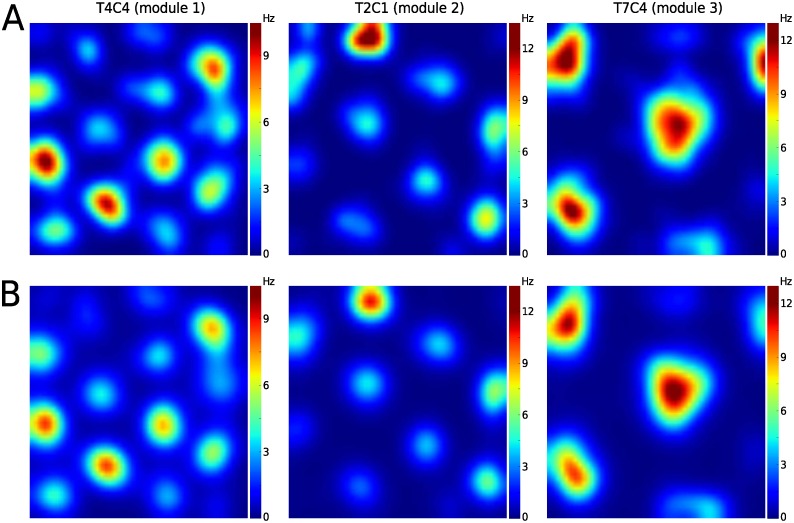
Grid cell spatial firing rate map.The smoothed rate maps from the original spike data (panel A) and synthetic spike data (panel B). Three example grid cells from the three different modules identified in data set 1 are shown here: left column, module 1 (T4C4 is cell identity—tetrode 4 cell 4), middle column, module 2, and right column, module 3. The synthetic data (panel B) was generated using Eq. 1 (with H
i(t) determined by the inferred values for the Gaussian basis functions plus a constant field) and the trajectory of the rat. The rate maps in both panel A and B were generated by first binning the spike data into 3 cm spatial bins, for which the mean rate was calculated and then smoothed using a Gaussian filter (standard deviation = 2 bins).